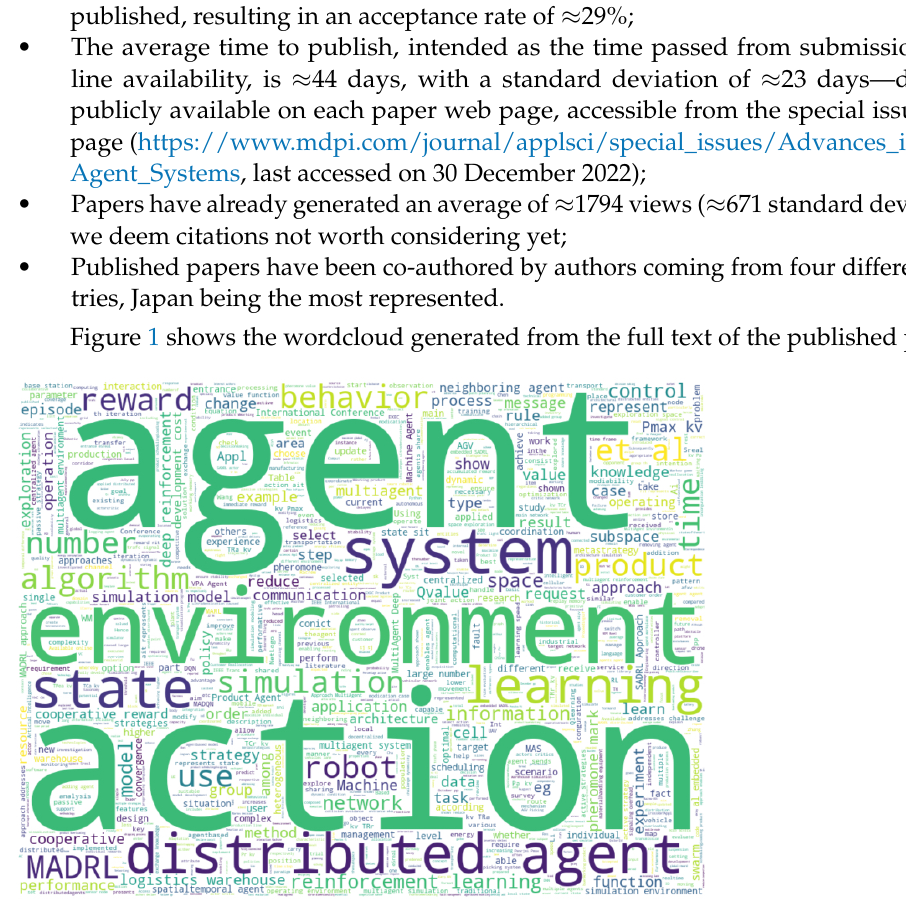
Figure 1. Wordcloud generated from the full text of each publication of the Special